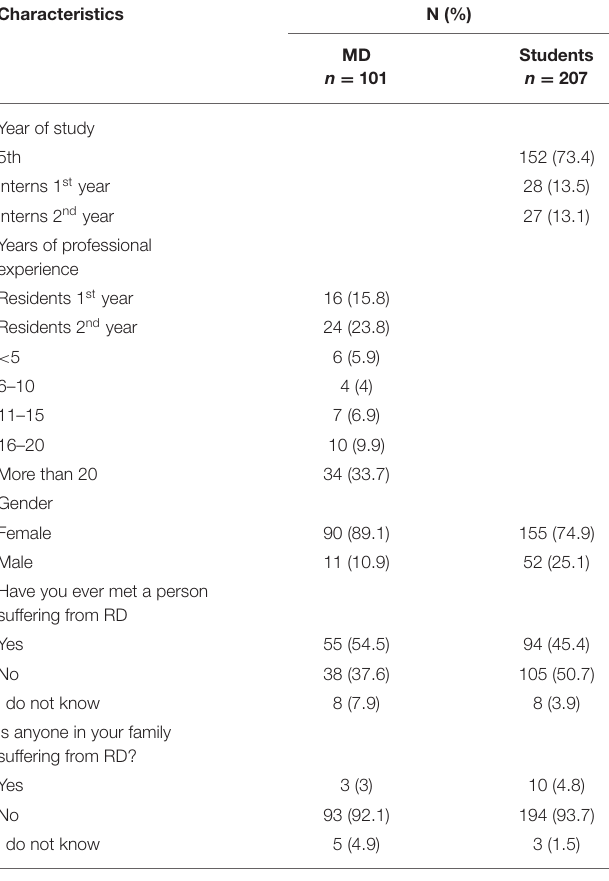
TABLE 1 | Socio-demographic characteristics of respondents. TABLE 2 | Respondents’ knowledge about rare